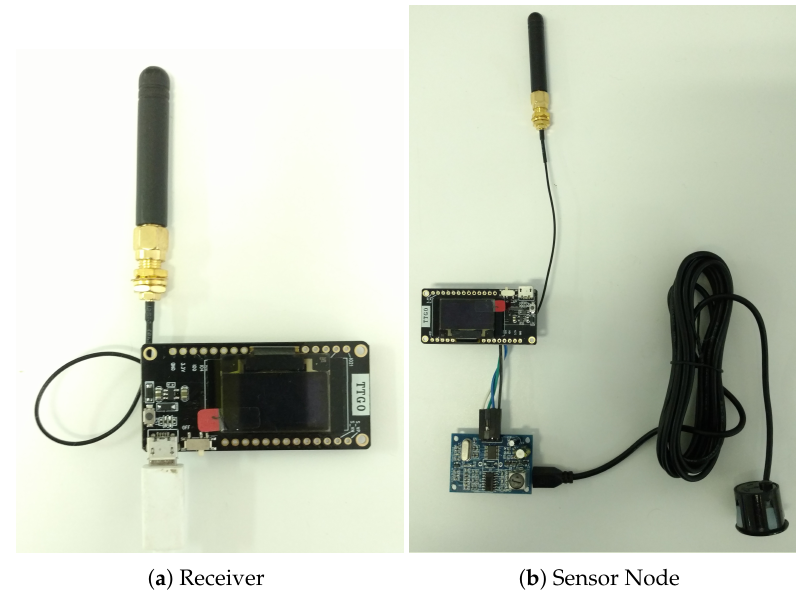
Figure 4. First prototype implemented.